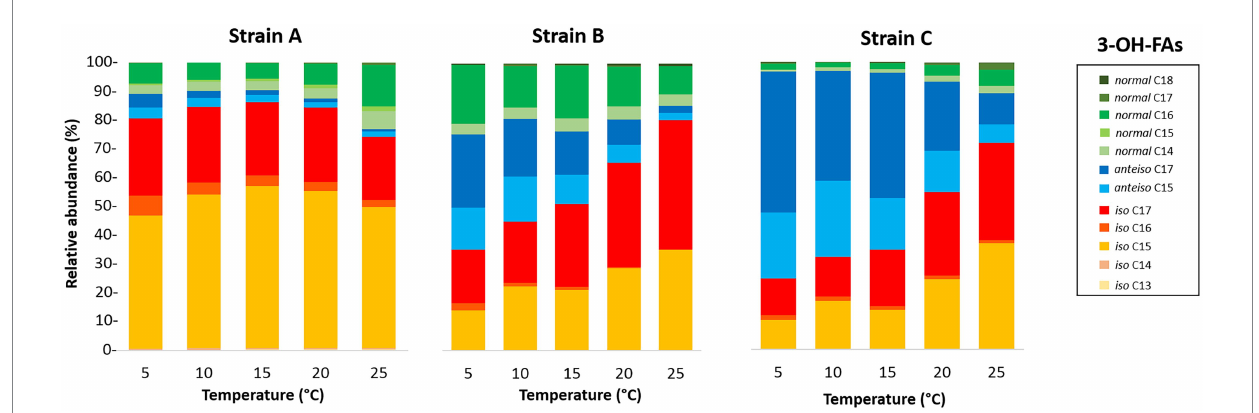
FIGURE 1 Variation of the relative abundances of 3-OH-FAs with temperature for the three Bacteroidetes strains isolated from different altitudinal soils of the French Alps. Strain A: Flavobacterium pectinovorum (98.78% similarity). Strain B: Pedobacter lusitanus NL19 (98.54% similarity). Strain C: Pedobacter panaciterrae (99.27%